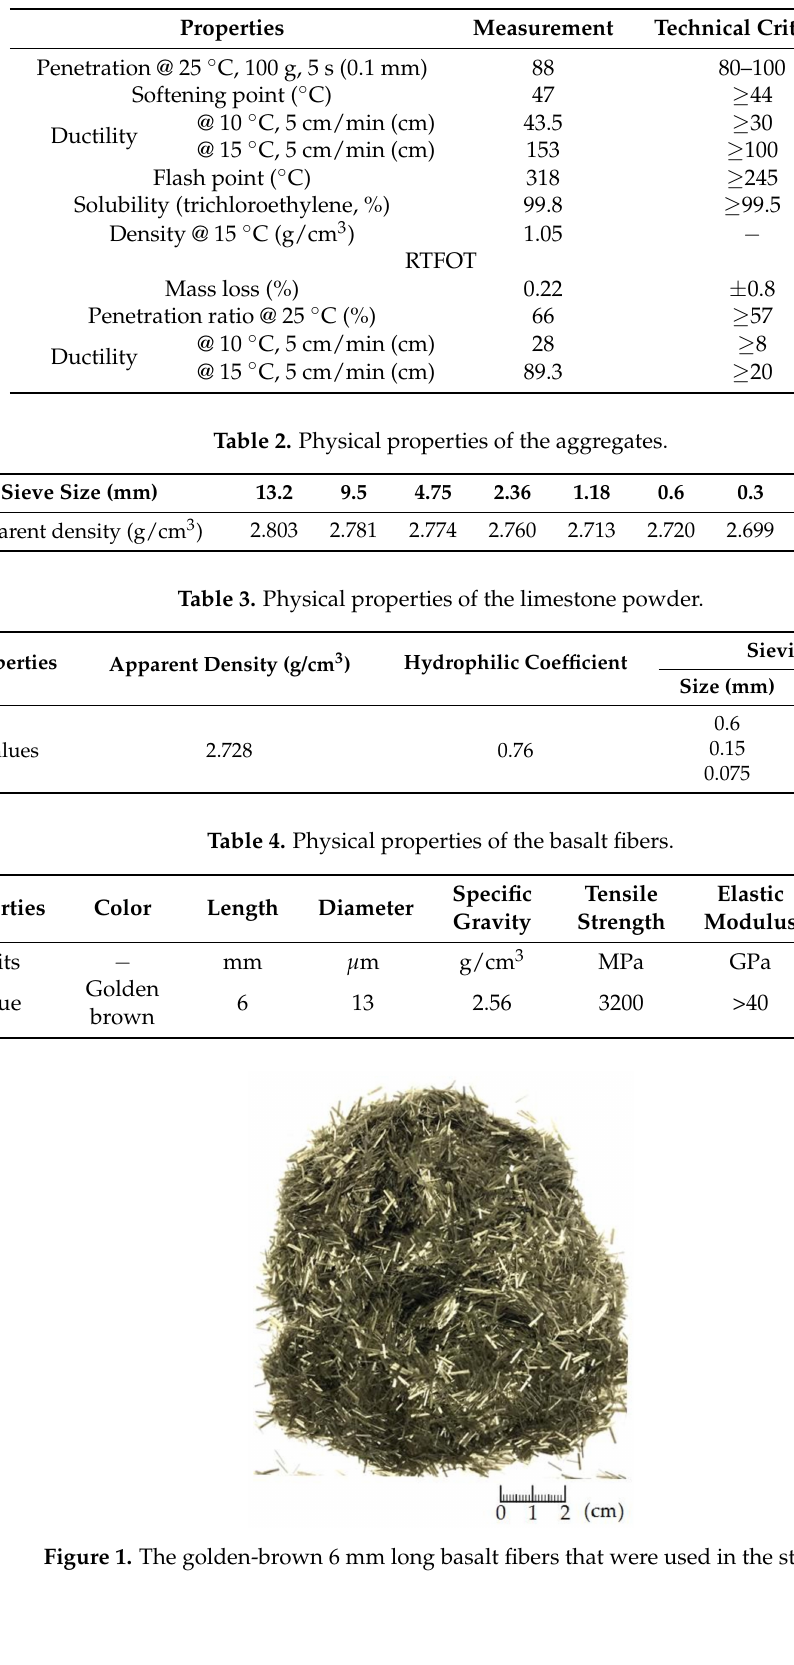
Table 1. Basic physical properties of the bitumen.